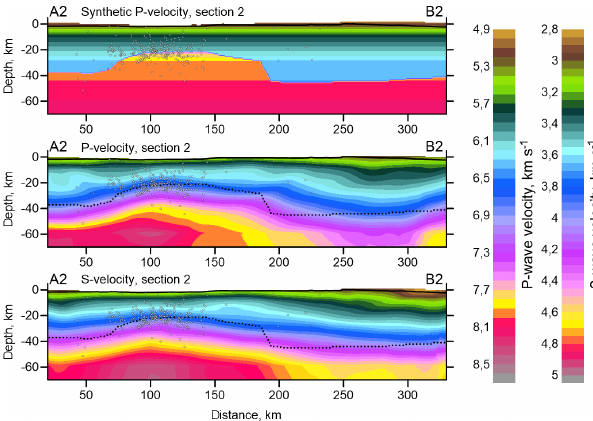
Figure 6. Synthetic test on recovering the Moho depth variations in Sect. 2 (see Fig. 2 for the location of the profile). The upper plot shows the synthetic model; the middle and lower plots show the reconstruction results for the P and S velocities, respectively. The dotted line depicts the synthetic Moho interface, and dots depict the earthquakes used for